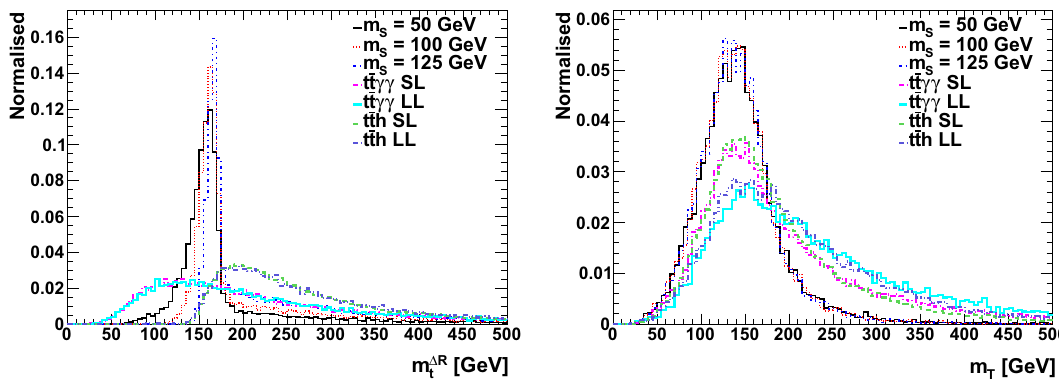
Fig. 3 (Left) The reconstructed top mass from the hardest two photons and the hardest jet. (Right) The transverse mass m T Table 5 Efficiency after each cut for the seven signal benchmark points